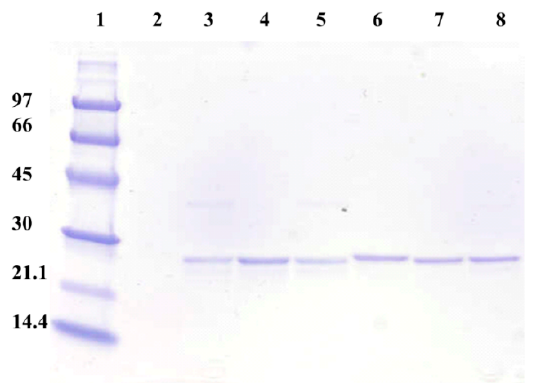
Figure 3. SDS-PAGE analysis of all purified Tt27-NOX variants. Lanes: (1) Molecular weight marker (kDa); (2) Empty lane; (3) K166/H174/Y194 variant; (4) K166/H174/H194 variant; (5) R166/H174/H194 variant; (6) K166/R174/Y194 variant; (7) R166/H174/Y194 variant; and (8) R166/R174/H194 variant.